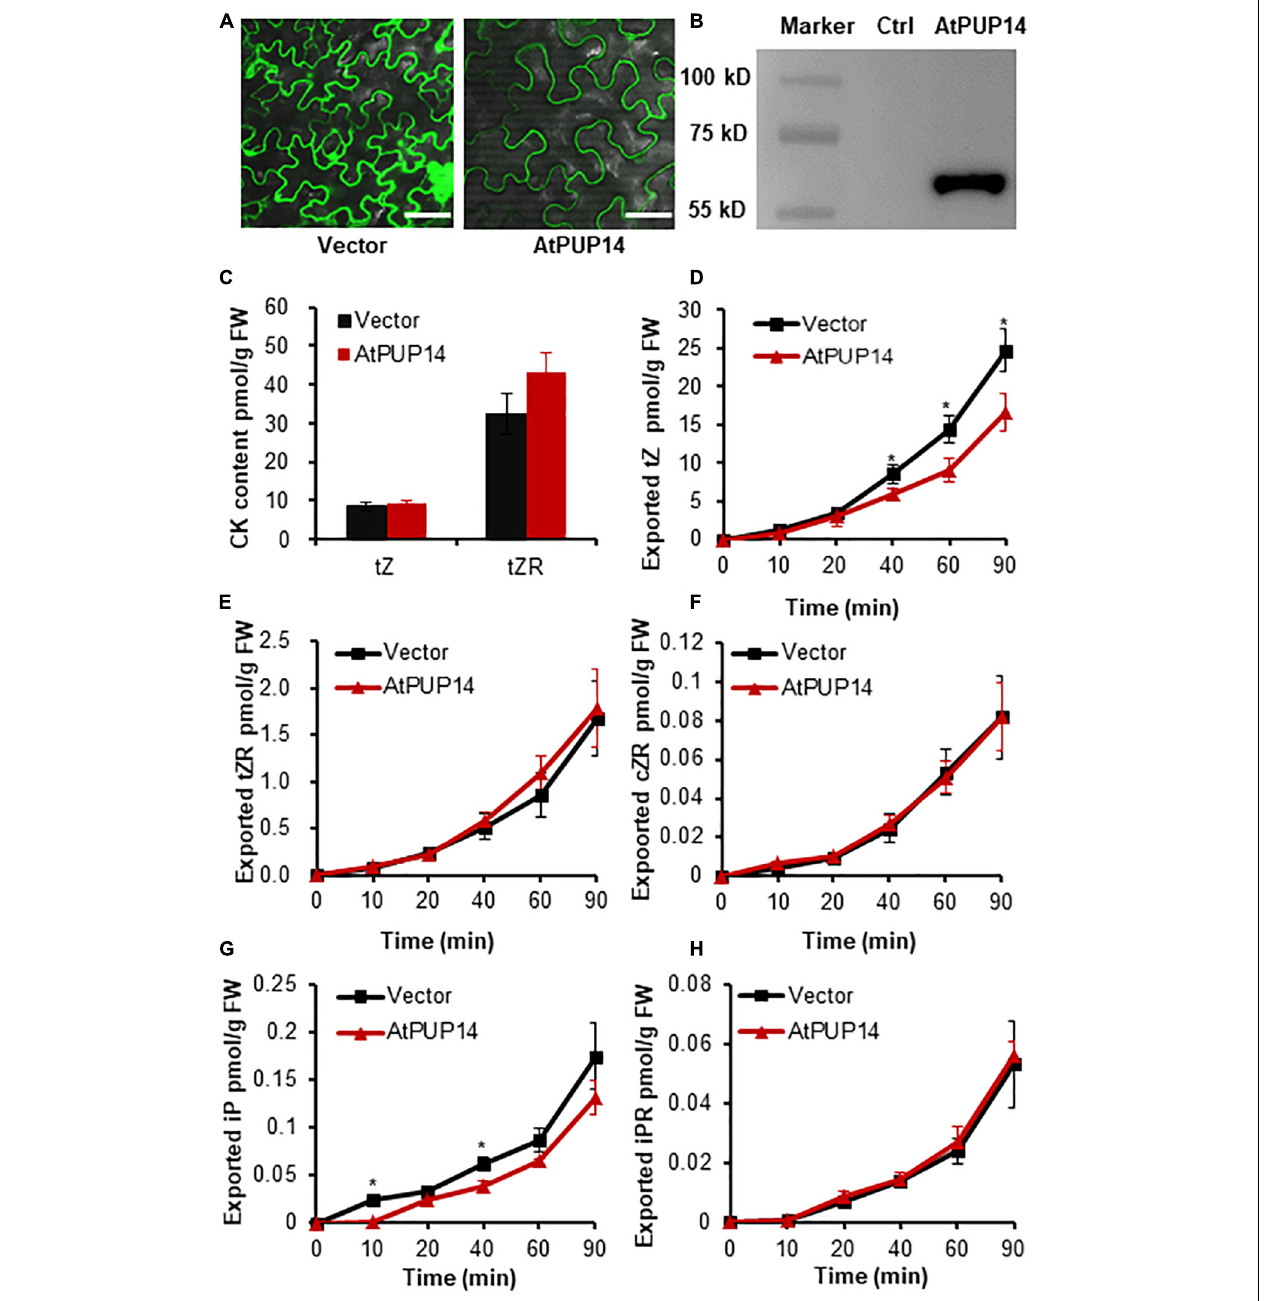
FIGURE 4 | AtPUP14-mediated influx transport of cytokinins in the agroinfiltrated tobacco leaves. (A) Transient expression of GFP and AtPUP14-GFP in tobacco leaves imaged by confocal microscope. Bar = 50 µ m. (B) Immunoblot analysis ofAtPUP14-GFP fusion protein expression in tobacco leaves. M, marker; AtPUP14, total protein from tobacco leaves with transient expression of PUP14 pro :AtPUP14-GFP ; Ctrl, control, total protein from non-transgenic tobacco leaves. (C) Quantification of tZ and tZR in tobacco leaves expressing GFP and AtPUP14-GFP before the TSAL assay. (D–H) Quantification of exported cytokinins of tZ, tZR, cZR, iP, and iPR from tobacco leaves transformed with AtPUP14-GFP or GFP in the incubation buffer at the time points of 0, 10, 20, 40, 60, and 90 min. Data are means ± SE ( n = 4). *, **, and *** indicate P -values of P < 0.05, P < 0.01, and P < 0.001, respectively, from Student’s t -test. t Z, trans -zeatin; t ZR, trans -zeatin riboside; c ZR, cis -zeatin riboside; iP, isopentenyladenine; iPR, isopentenyladenosine.